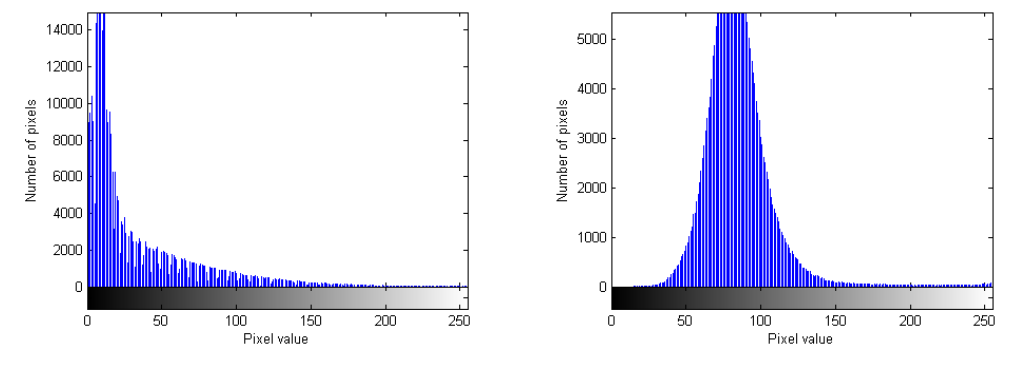
Figure 6. ( a , b ) The histograms of the statistical image.